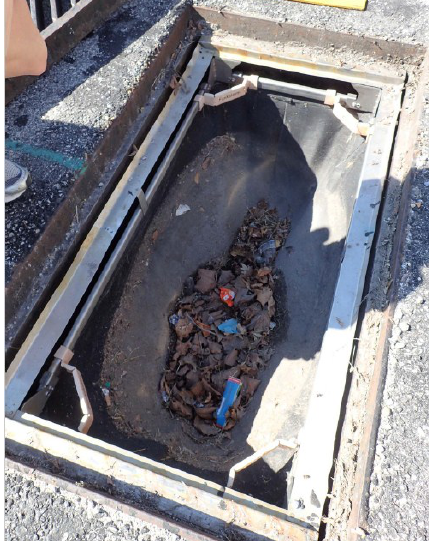
Figure 2. Trash guard installed in the GI1 inlet structure (Date: 18 October 2016).